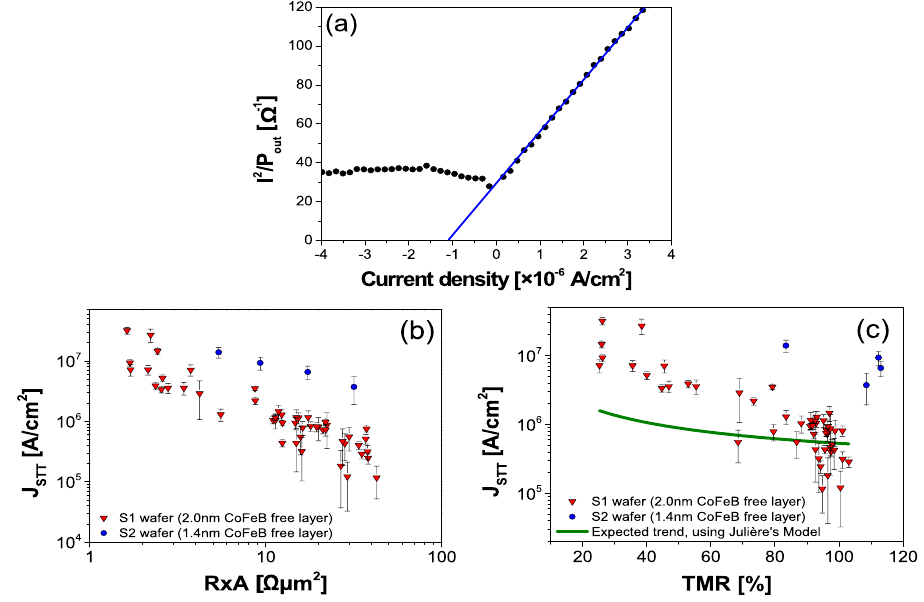
Figure 4. Critical current density for STT-induced oscillations. ( a ) Example of the determination of the critical current by the x-axis interception of the linear fit of I²/P in the thermally activated region. Calculated values of J STT as a function of ( b ) R × A and (c) TMR for t CoFeB = 2.0 nm (red triangles) and t CoFeB = 1.4 nm (blue